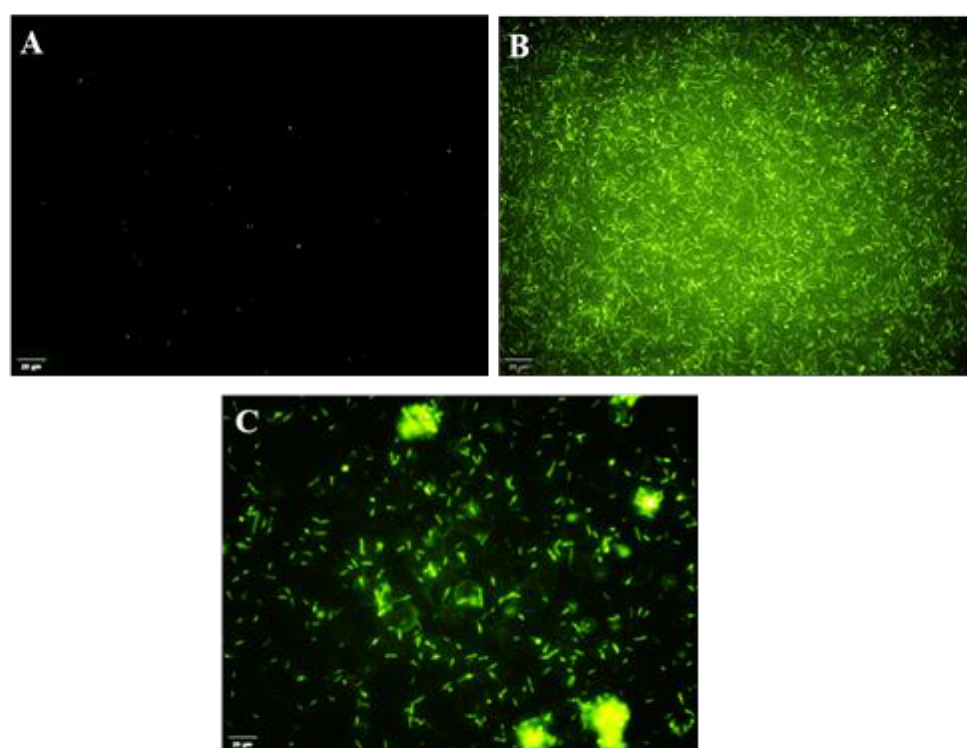
Figure 8. Accumulation of reactive oxygen species in R. solanacearum cells treated with DAPG at 90 µg/mL concentration at 6 h incubation time. Green fluorescence indicates the DCFDA dye binds with ROS accumulation in R. solanacearum cell membrane. ( A ) Control (untreated), ( B ) tetracycline and ( C ) DAPG. Scale bar: 20 µm.